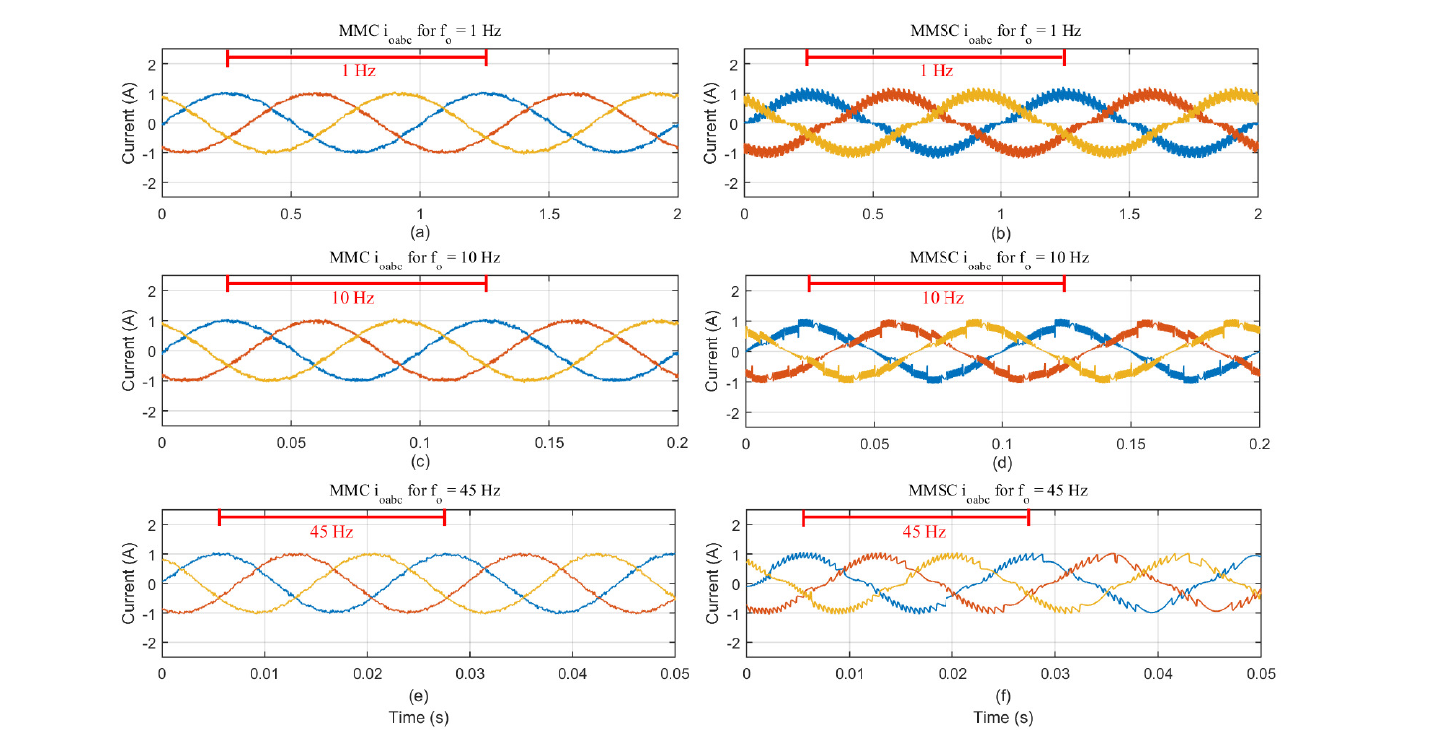
Figure 8. Experimental results. ( a , c , e ) MMC load current for the cases in which f o = 1,10 and 45 Hz, respectively. ( b , d , f ) MMSC load current for the cases in which f o = 1,10 and 45 Hz, respectively.